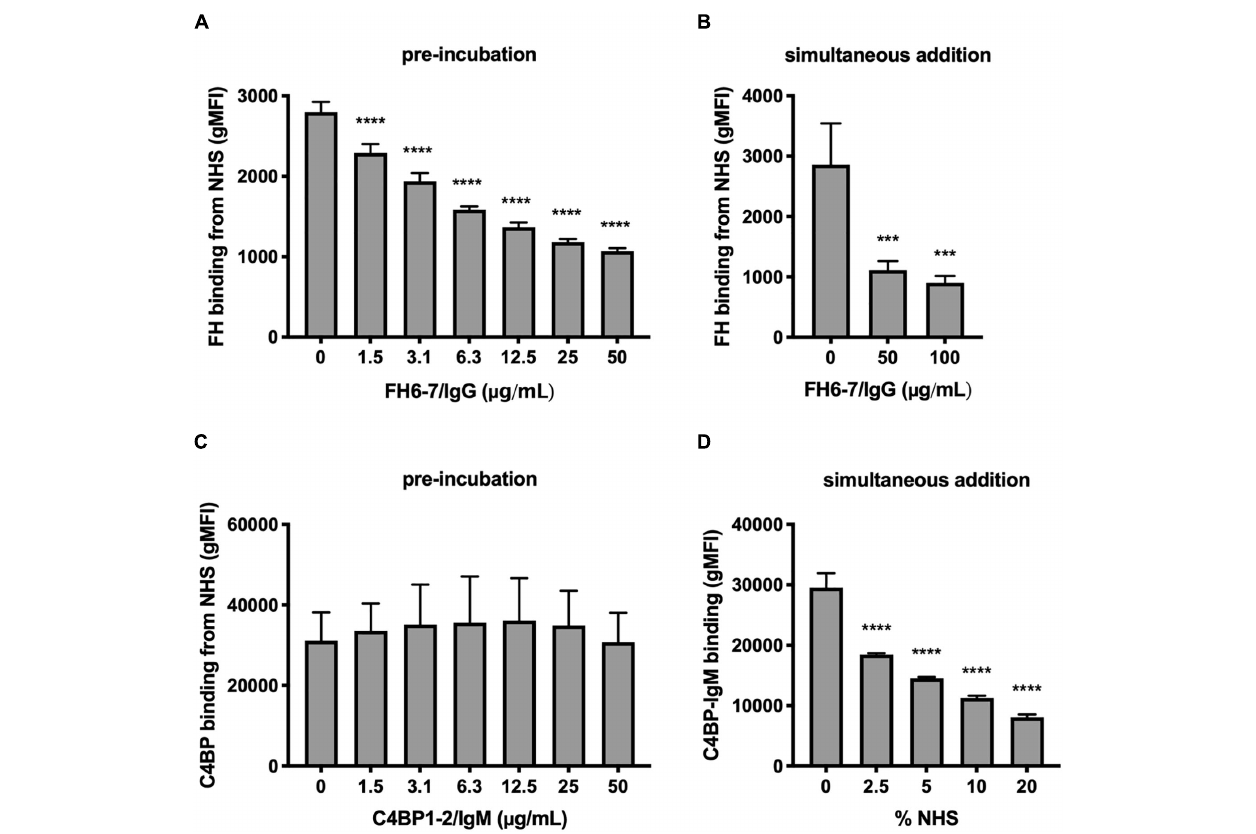
FIGURE 2 | FH6-7/IgG competes out serum FH, but C4BP1-2/IgM does not compete out serum C4BP. (A) M. catarrhalis were pre-incubated in increasing amounts of FH6-7/IgG, followed by the addition of OmCI-treated serum (C5-inhibitor). The binding of FH from NHS was assessed by flow cytometry using antibodies specific to domains present in serum derived FH but absent on the fusion proteins. (B) FH6-7/IgG and NHS were added simultaneously to the bacteria and binding of FH from NHS was assessed. (C) M. catarrhalis pre-incubated in increasing amounts of C4BP1-2/IgM, followed by OmCI-treated serum were tested for the binding of C4BP from NHS by flow cytometry using antibodies specific to domains present in serum derived C4BP but absent on the fusion proteins. (D) Alexa Fluor 488-labeled C4BP-IgM was added simultaneously with differing concentrations of OmCI-treated serum to bacteria to assess the binding of the fusion protein. Mean ( ± SD) from three independent experiments are shown. Statistical significance of differences was calculated using one-way ANOVA with Dunnett’s post-test; *** p < 0.001 and **** p < 0.0001.